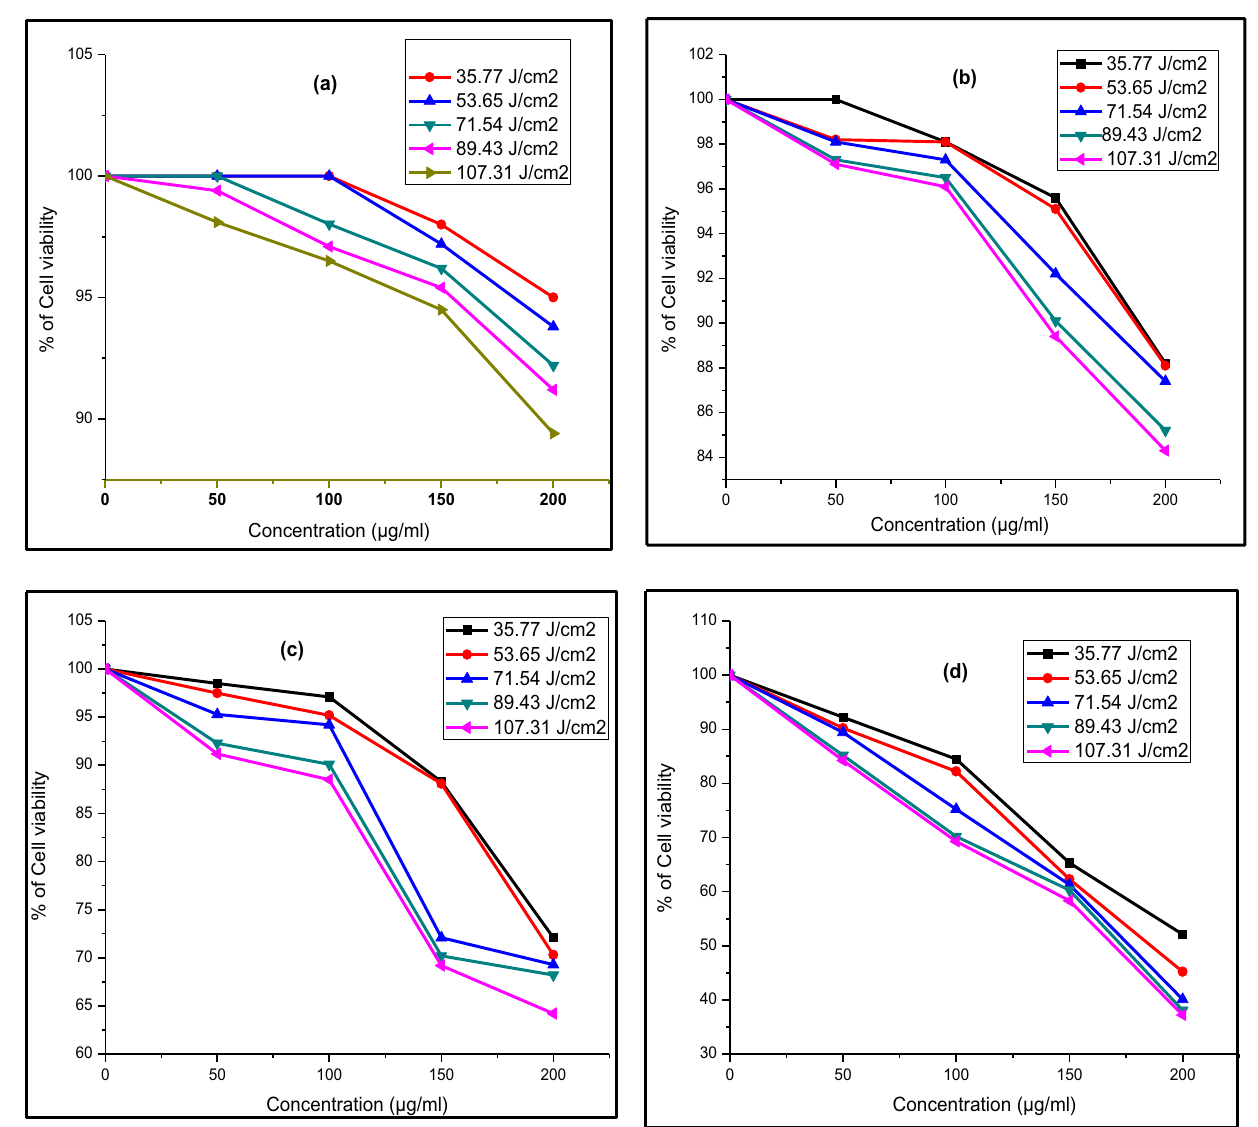
Figure 12. Cell viability of CS-CT nanocomposites on HeLa cells after ( a ) 8 h, ( b ) 12 h, ( c ) 16 h and 0 ( d ) 24 h of